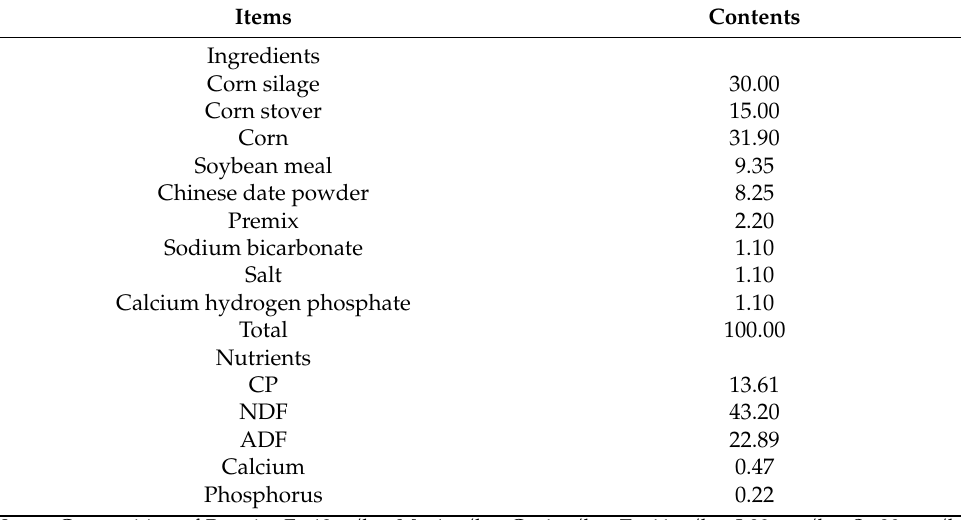
Table 1. Ingredients and chemical composition of the diet for the steers as rumen fluid donor (% DM).